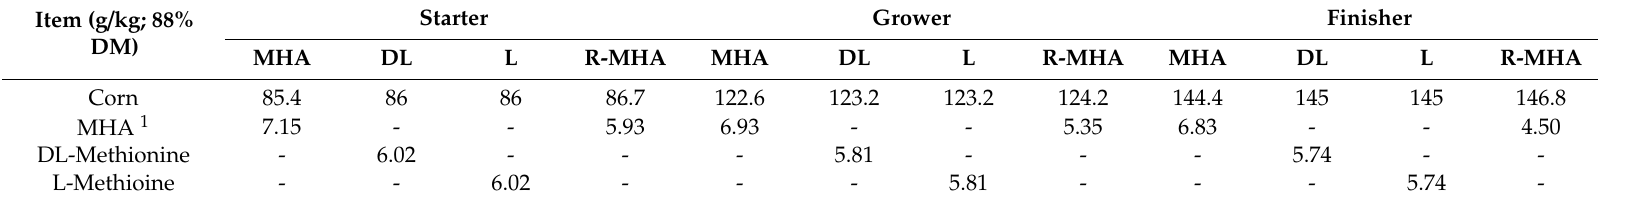
Table 1. The content of corn and the respective methionine sources in experimental diets.